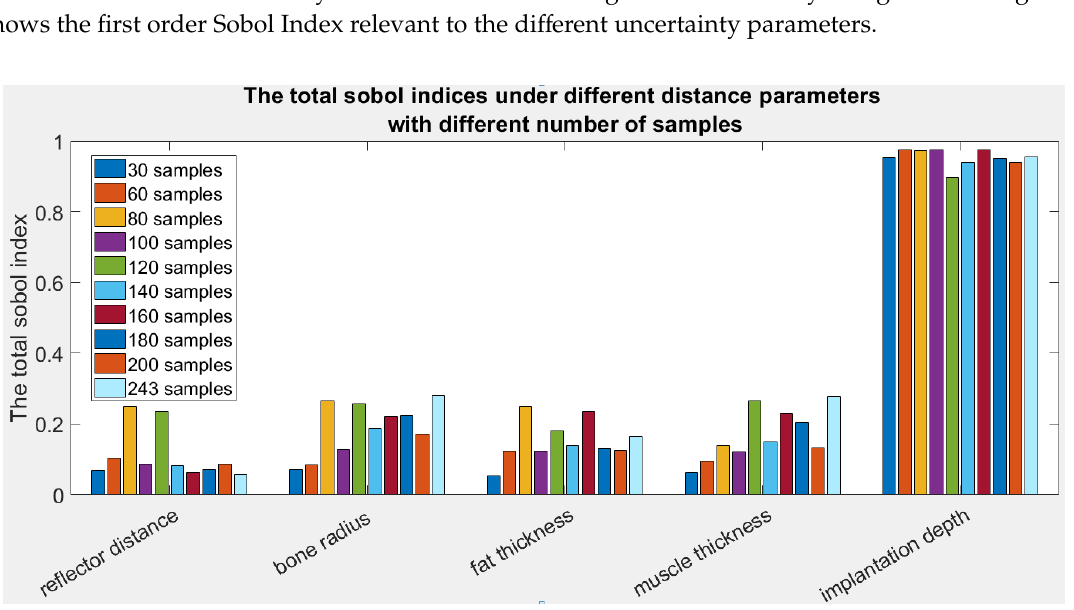
Figure 4. Leave-One-Out (LOO) Error in log VS Number of samples.